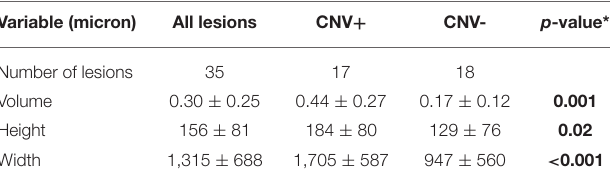
TABLE 3 | Quantitative analysis of lesions of PIC on spectral domain optical coherence tomography (SDOCT). Variable (micron) All lesions